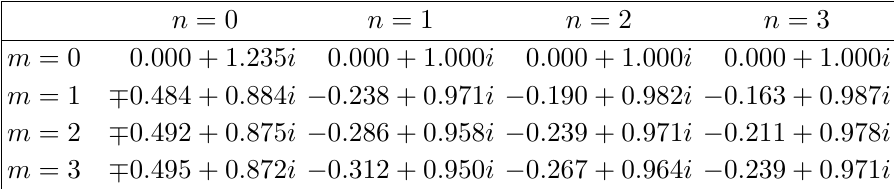
Table 1 . Values of the modulus τ at the global minima of the potential V ( τ, ¯ τ ) , eq. (2.12), obtained numerically for various m and n .